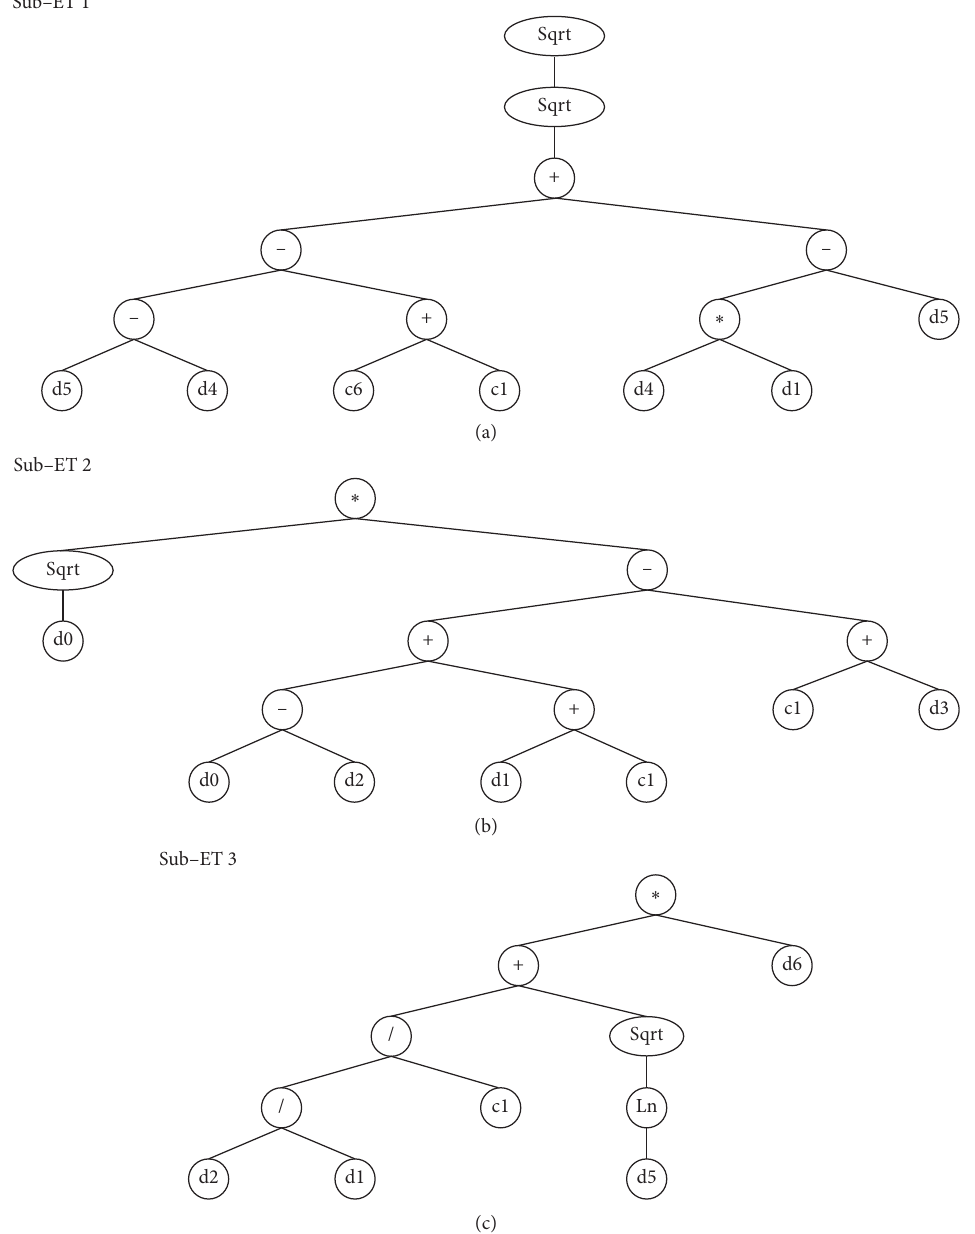
Figure 7: Expression tree of the model formulated for CBR (where d0: HARHA, d1: w C6: 438.77, Sub-ET1 C1: 5.829, Sub-ET2 C1: -3341.12, Sub-ET3 C1: